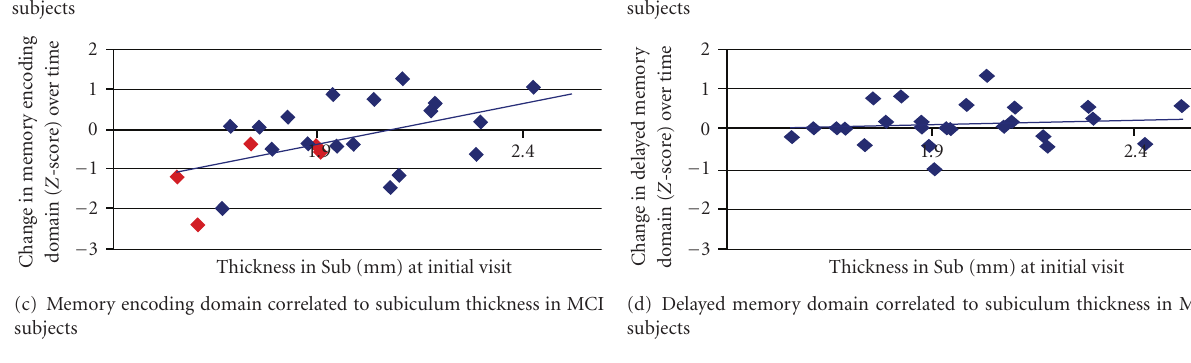
Figure 2: Correlation of subregional thickness in MCI subjects at their initial visit to decline in averaged Z score performance within cognitive domain over time. Scatterplots display: ERC thickness related to decline in Memory Encoding Domain ( r = 0 . 34; P = . 003, (a)); ERC thickness related to Z -change in Delayed Memory Domain ((b); not significant); Sub thickness related to decline in Memory Encoding Domain ( r = 0 . 26; P = . 011, (c)); Sub thickness related to Z -change in Delayed Memory Domain ((d); not significant). MCI subjects who converted to AD are highlighted in red on the Encoding Domain charts (a, c) to illustrate the relative thickness in ERC and Sub cortex compared to subjects who did not